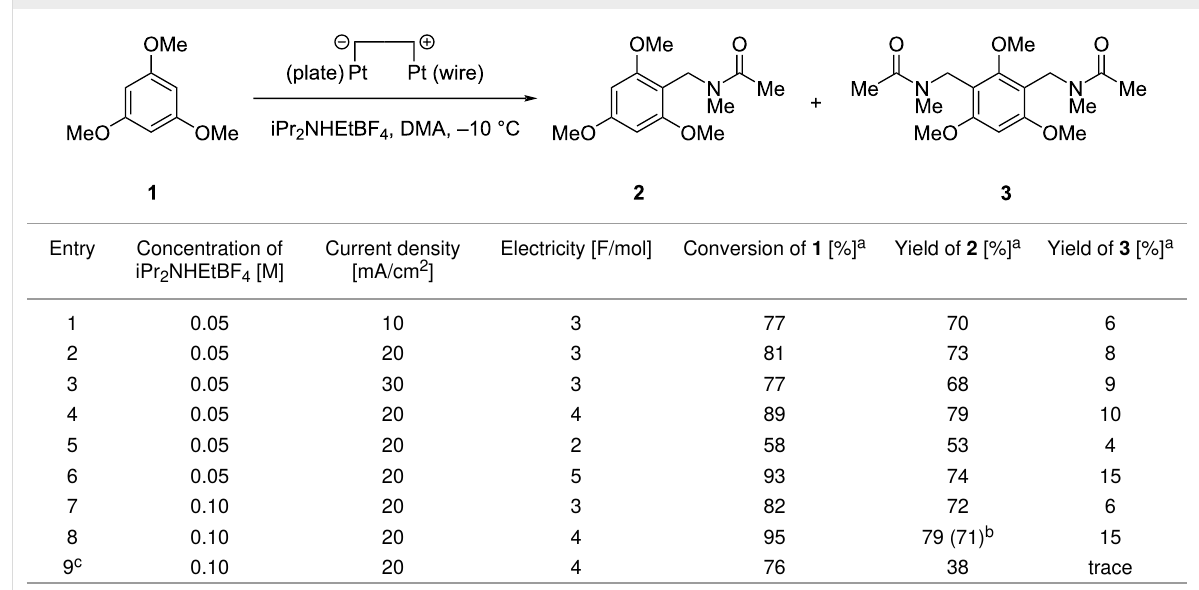
Table 3: Screening of reaction conditions in electrochemical